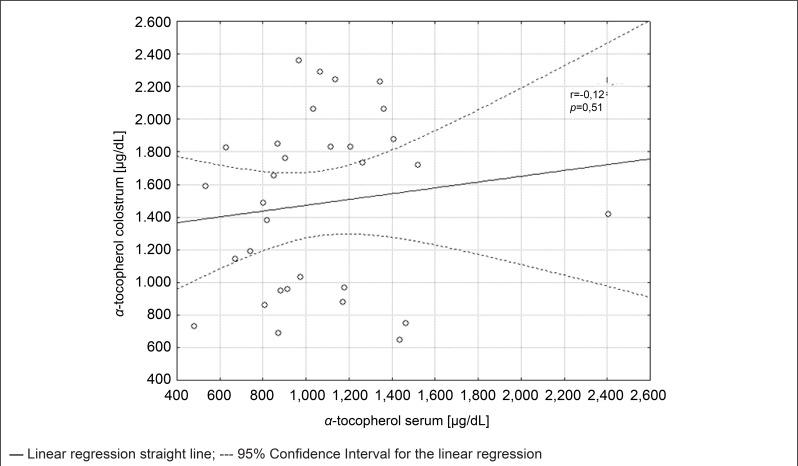
Correlação entre a concentração de a-tocoferol no soro e no colostro de
lactantes do Grupo Controle